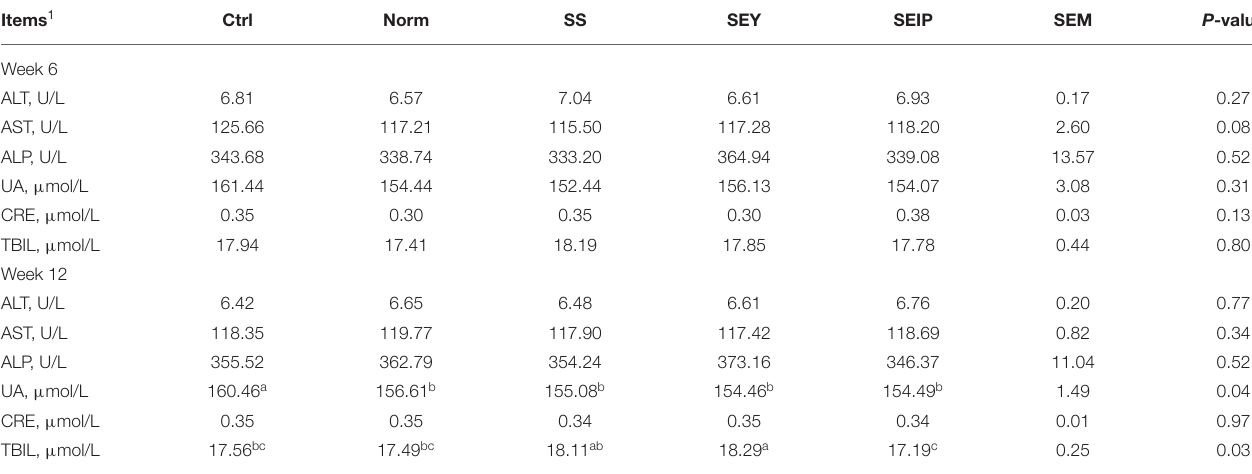
TABLE 5 | Effects of dietary Se sources on blood biochemical indicators of laying hens. Items 1 Ctrl Norm SS SEY SEIP SEM P -value